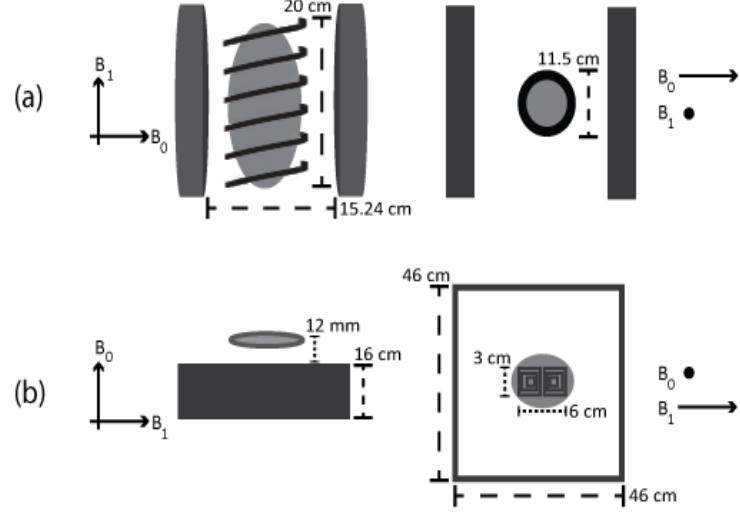
Figure 1. Diagrams comparing the conventional low field NMR instrument in ( a ) to the single sided instrument in ( b ). The primary difference between these two geometries is that applied rf interacts with the entire sample in (a) and only a fraction of the sample in (b) as shown by the shaded gray area.